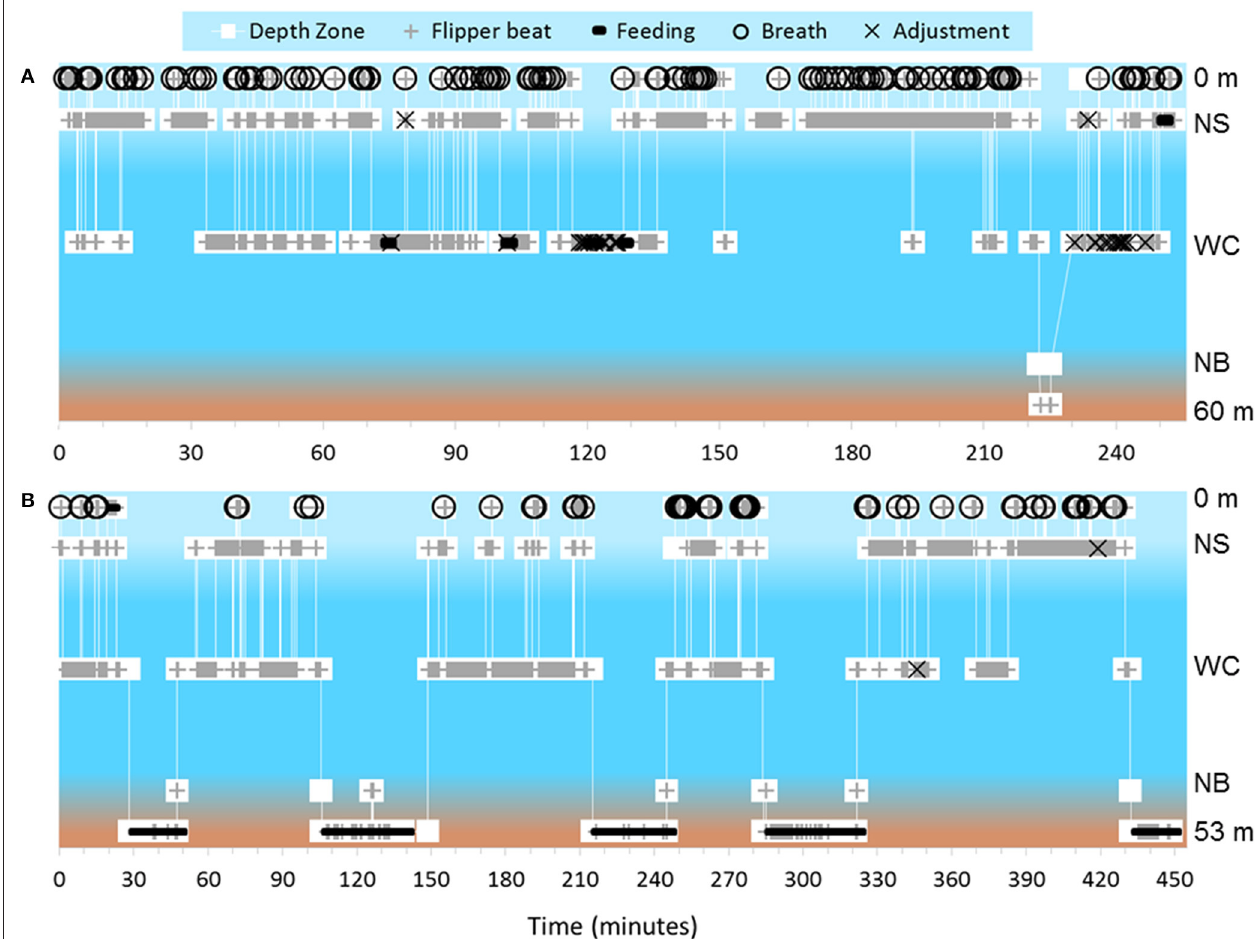
FIGURE 2 | Depth zones are based on the coding scheme and are as follows from top to bottom: 0m, Surface; NS, Near Surface; WC, Water Column; NB, Near Bottom; 60m and 53m respectively, Bottom. (A) Dive profile for turtle that exhibited both pelagic foraging and a benthic dive during the course of filming. This turtle primarily foraged on gelatinous zooplankton, and this pelagic foraging behavior yielded a swim pattern with a particularly high amount of adjustment events. Bottom depth was 60 m. (B) Dive profile of the longest tracked turtle. This turtle dove five times within ∼ 7 h and exhibited active benthic foraging each time. Bottom depth was 53